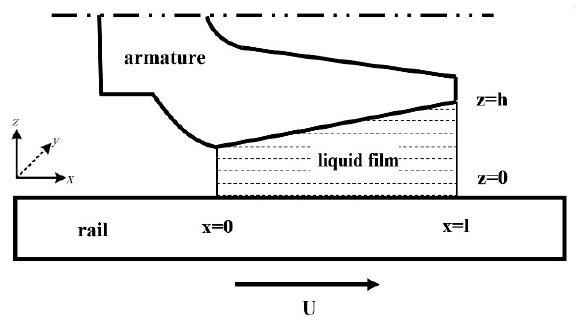
Figure 1. Schematic diagram of the liquid film of the A/R contact interface.